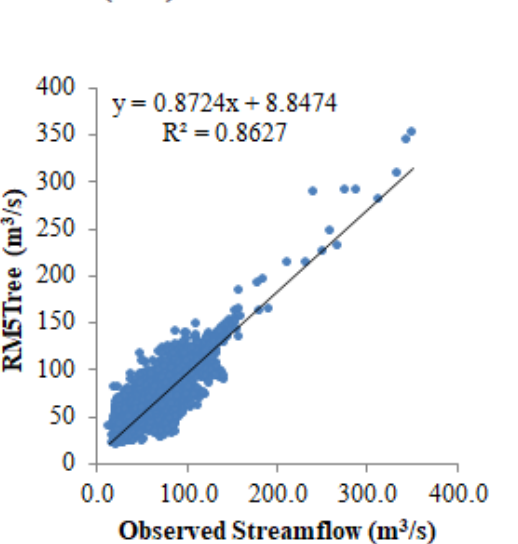
Figure 6. Scatterplots of the observed and predicted streamflow by RM5Tree, M5Tree, RBFNN, ANN, and MARS models in the test period of Ostavallselet Station (upstream).